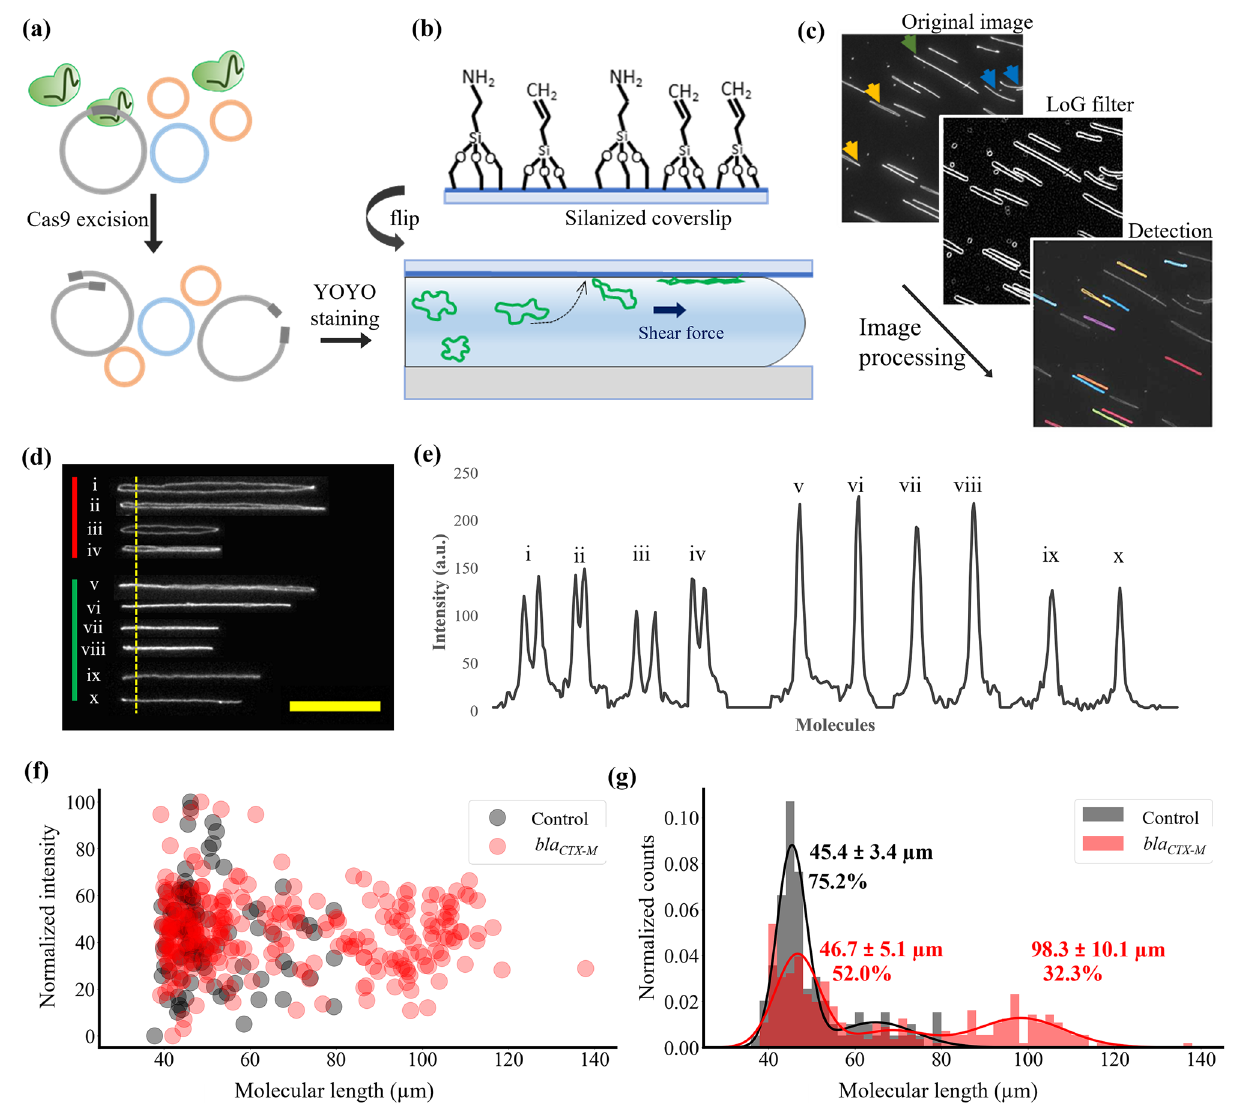
Figure 1. Experimental workflow. ( a ) Cas9-gRNA is added to the plasmid sample. If the AMR gene is present, Cas9 makes a double-stranded excision, resulting in plasmid linearization. ( b ) Glass coverslips are functionalized with a mixture of silanes with amine and vinyl terminal groups. DNA molecules are stained with YOYO-1 and stretched by capillary force between the silanized coverslip and a glass slide. ( c ) Image processing to detect molecules. A Laplacian of Gaussian (LoG) filter is used for edge detection and molecular length, width, eccentricity, and straightness filters are used to accept or reject the detected molecules. Examples of molecules not accepted are marked with yellow (too wide), blue (too curved) or green arrows (overlapping molecules), respectively. ( d ) Representative images of molecules observed during imaging. Molecules i-iv (red bar) are rejected and molecules v-x (green bar) are accepted. ( e ) Intensity profile for molecules in ( d ) along the dotted yellow line. Intensity is higher where two strands of the circular plasmid are localized together. Scale bar 15 µm. ( f ) Length vs. intensity plot for a sample carrying a single plasmid. Data for Cas9 targeting the bla CTX-M gene is shown as red dots and control as black dots. ( g ) Length histograms of the data in ( f stretching, the DNA molecules are in the air phase and the samples are dried/baked (and sometimes rehydrated) before imaging 27 . In contrast, we did not use an air–liquid interface to stretch DNA and in our setup, combing took place entirely in the liquid phase. Surface modification with ATMS and APTES resulted in a mix of vinyl (hydrophobic) and amino (hydrophilic and positively charged) groups on the glass surface. When the liquid was pulled between the two glass surfaces, the DNA molecules attached to the amino groups on the top glass surface by electrostatic interaction. At the same time, the molecules also experienced a shear-induced deformation/ stretching force 38 , which stretched the DNA in the direction of the fluid flow. The combination of the binding and stretching forces that DNA experienced at the solid–liquid interface resulted in DNA molecules partitioning onto the glass surface in an almost fully stretched conformation, where they were stabilized by multiple attach- ment points. Since our method does not rely on fraying DNA ends, it is more tolerant to solution pH and could